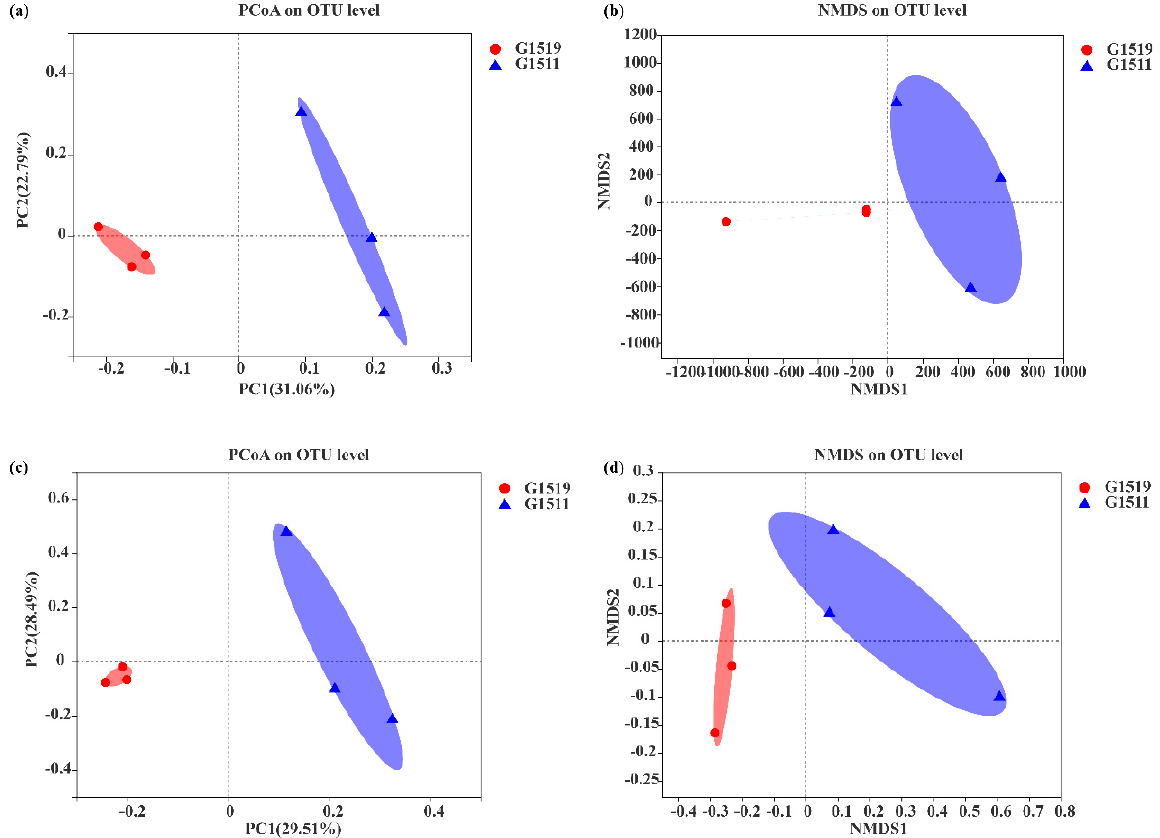
Figure 1. Comparison of soil bacteria and fungi in the rhizospheres of two pumpkin cultivars (G1519 and G1511). ( a ) PCoA analysis of the soil bacterial community at the OTU level. ( b ) NMDS analysis of soil bacterial communities at the OTU level. ( c ) PCoA analysis of soil fungal communities at the OTU level. ( d ) NMDS analysis of soil fungal communities at the OTU